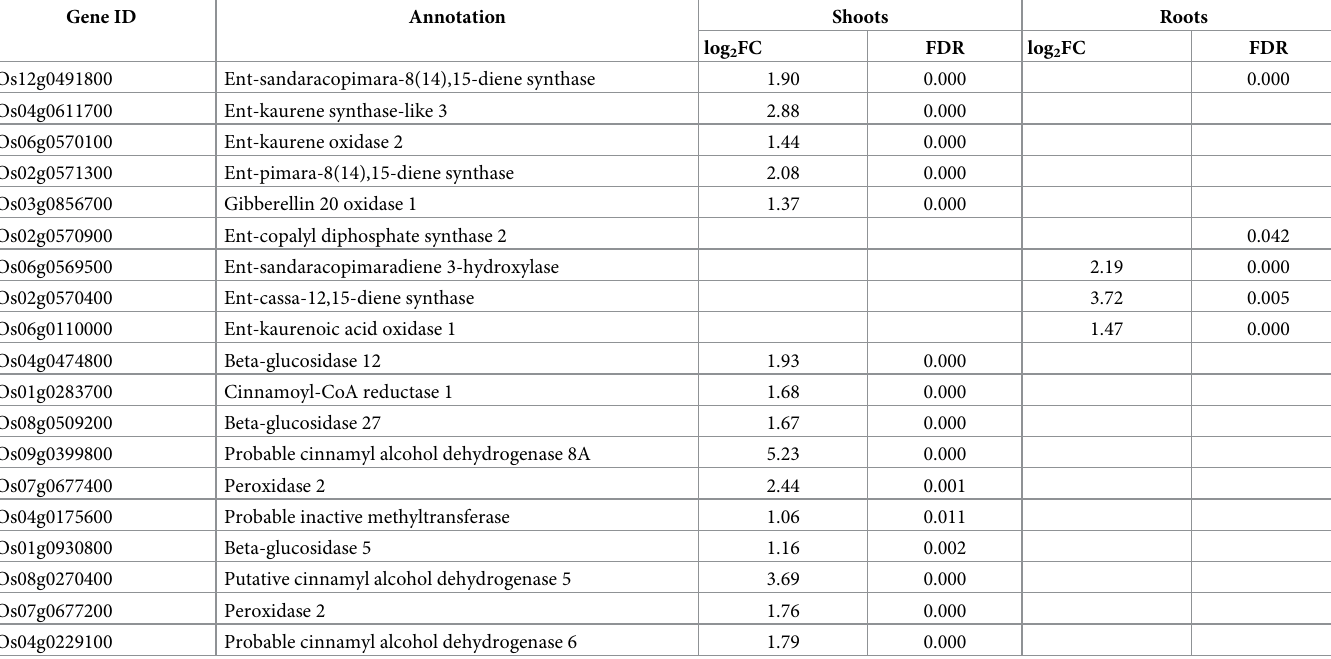
Note: log 2 FC = log 2 Fold Change, FDR = false discovery